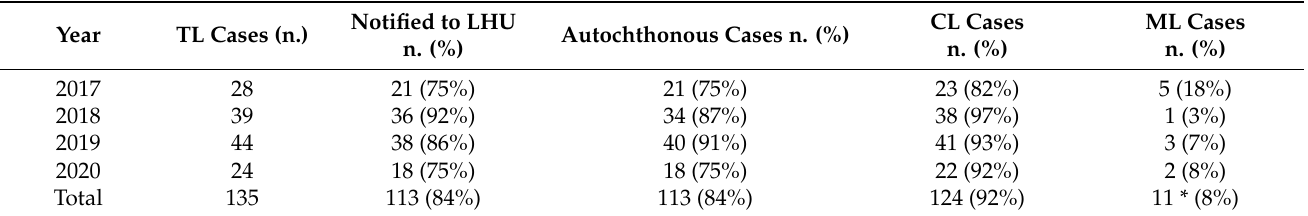
Table 1. Tegumentary leishmaniasis cases that were identified in the Emilia-Romagna region, north- eastern Italy, 2017–2020.